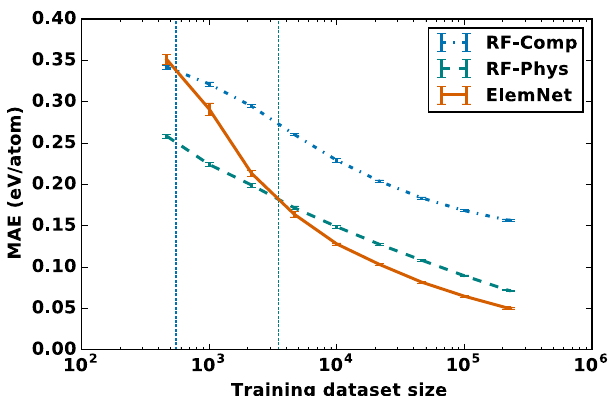
Figure 3. Impact of training dataset size on the prediction accuracy of ElemNet (DNN model) using elemental compositions only and the best conventional ML model, Random Forest, with either raw elemental compositions (RF-Comp) and physical attributes (RF-Phys). The training and test sets are created during the ten-fold cross validation from the OQMD; different random subsets of the training set with sizes ranging from 464 to 230, 960 are created using a logarithmic spacing for this analysis. Training dataset size has more impact on ElemNet (deep learning model) compared to Random Forest models, but ElemNet performs better than Random Forest for all size greater than 4 k